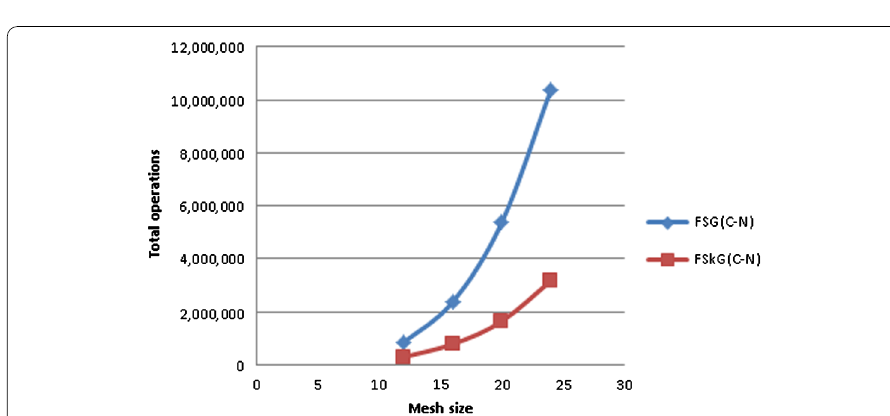
Figure 12 Graph of total operations when α = 0.70 of Example 2